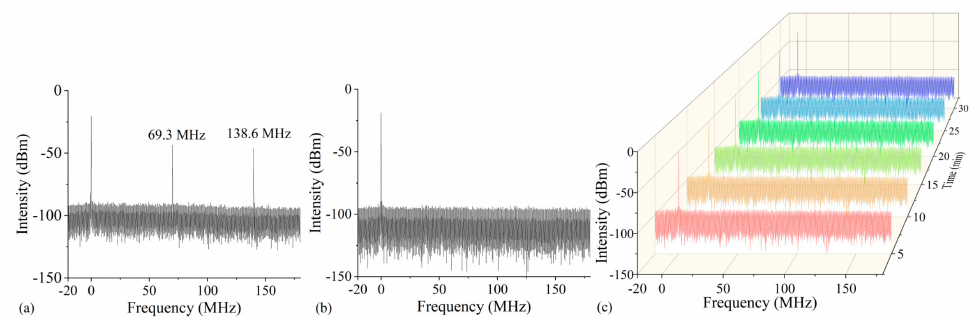
Figure 4. Beating spectra at RF with a 3.6 W pump. ( a ) Case 1 and ( b ) Case 2. ( c ) Stability of the RF spectrum in Case 2 during 30 min.